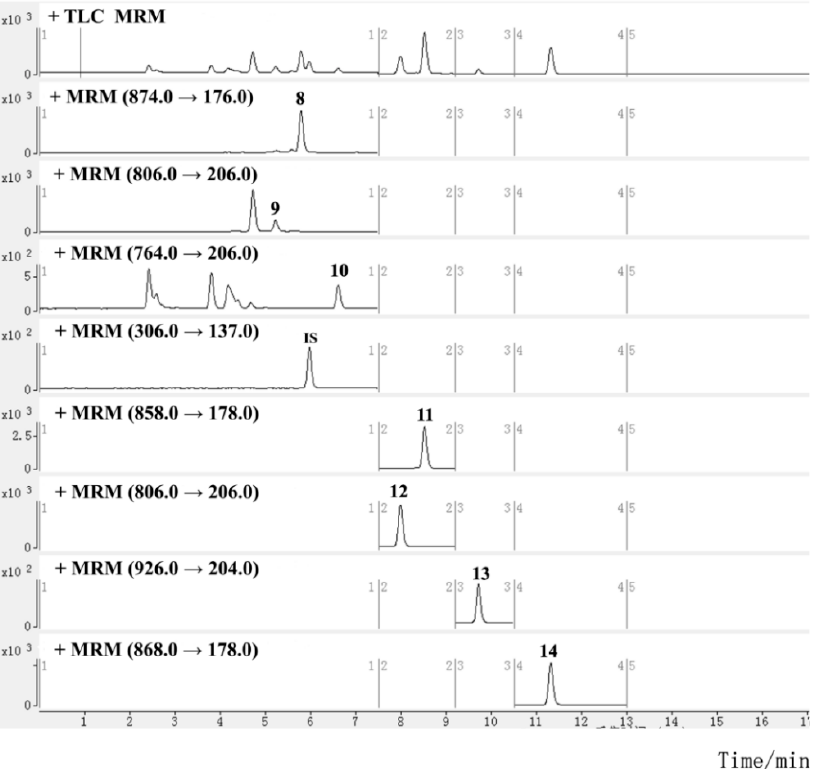
Figure 3. MRM chromatograms for investigated sesquiterpene alkaloids in TGTs (sample S2, the peak numbers correspond to the compound numbers in Figure 1).